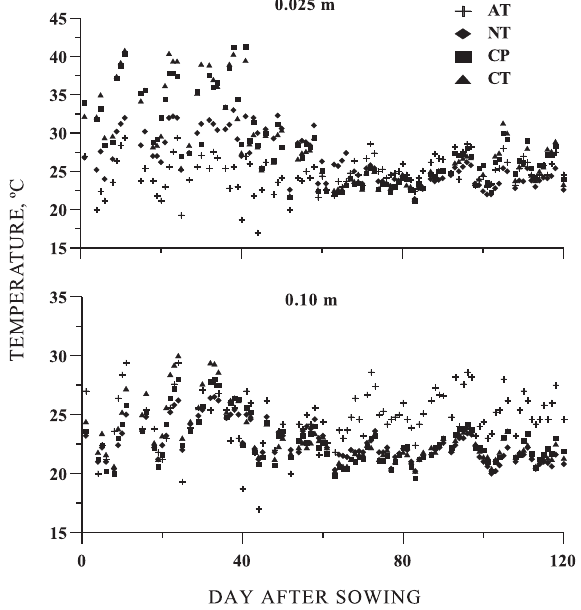
Figure 7. Volumetric moisture at 0.05 and 0.15 m depths (curves), and rainfall (bars) during